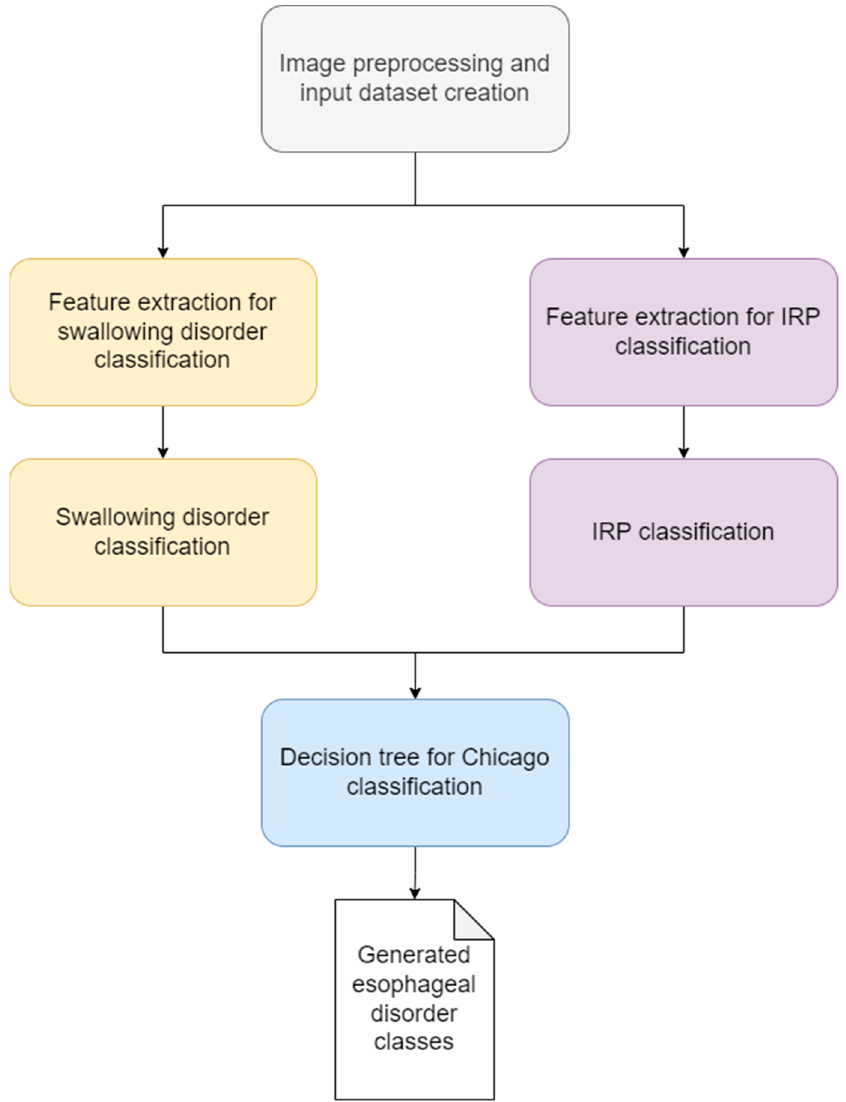
Figure 4. Block diagram of the final solution.